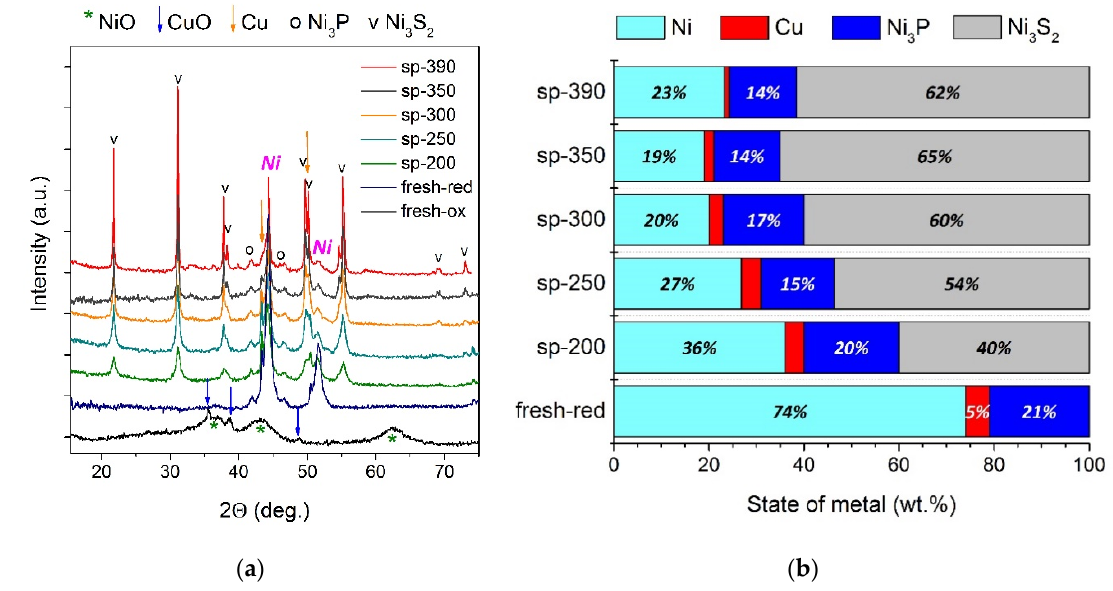
Figure 8. ( a ) X-ray diffraction patterns of NiCuMo-P-SiO 2 catalyst in an oxidized state (fresh-ox), Figure8. ( a )X-raydiffractionpatternsofNiCuMo-P-SiO 2 catalystinanoxidizedstate(fresh-ox),reducedstate reduced state (fresh-red), and after Py-SS hydrotreatment at 200 °C to 390 °C (sp-200/sp-250/sp- (fresh-red), and after Py-SS hydrotreatment at 200 ◦ C to 390 ◦ C (sp-200 / sp-250 / sp-300 / sp-350 / sp-390). 300/sp-350/sp-390). ( b ) Quantitative analysis of phase composition for fresh reduced and spent ( b ) Quantitative analysis of phase composition for fresh reduced and spent catalysts, based on the Rietveld catalysts, based on the Rietveld method.